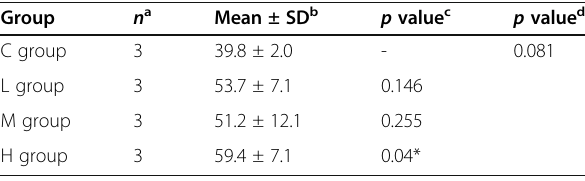
Table 3 Alveolar mean linear intercept in each group after 4 weeks of HONO